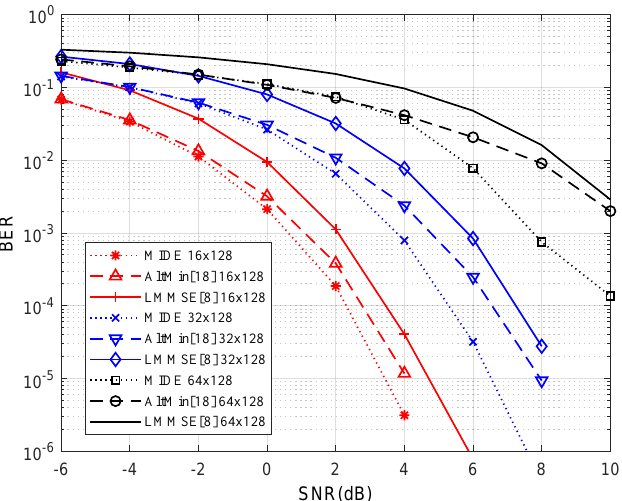
Figure 5. BER performance comparison of the AltMin algorithm, the LMMSE algorithm, and the proposed